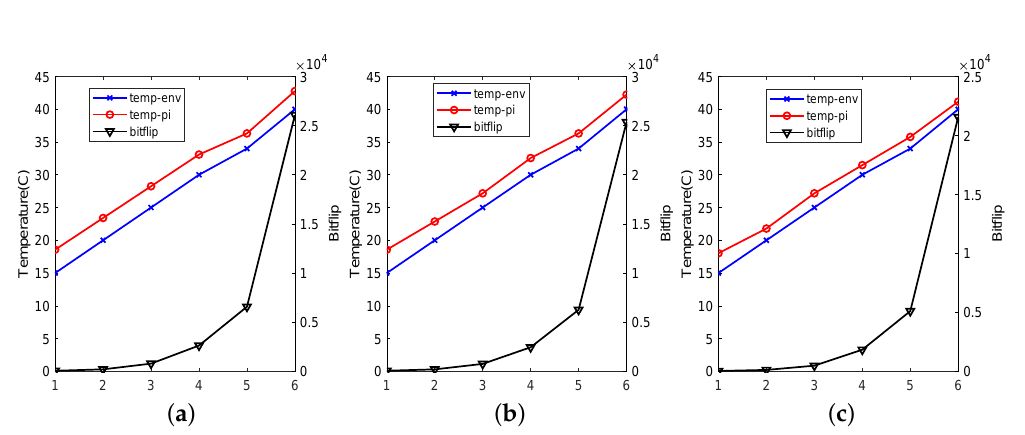
Figure 8. Test results of Rpi1, Rpi2 and Rpi3. The temperature of thermal chamber, temperature sensor on the systems on chip (SOC) and the number of bit flips (right y-ray) are shown in each plot. The x-ray is the number of iteration of tests under different tests conditions. Due to the heat production of function operation, the curve of temperature sensor on the SoC are always higher than the thermal chamber. ( a ) Test results of RPi1. ( b ) Test results of Rpi2. ( c ) Test results of Rpi3. Based on our measurements, we estimated α to be 0.2465 for Rpi1, 0.2432 for Rpi2 and 0.2659 for